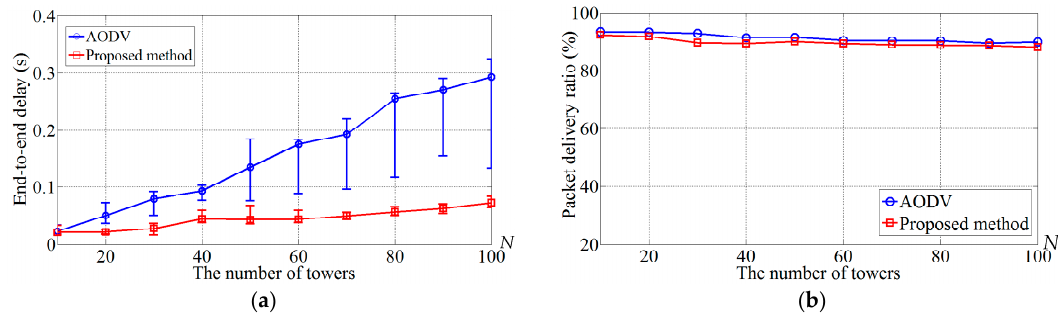
Figure 9. Routing Protocol performance different network scale. ( a ) average, maximum and minimum end-to-end delay; and ( b ) packet delivery ratio.